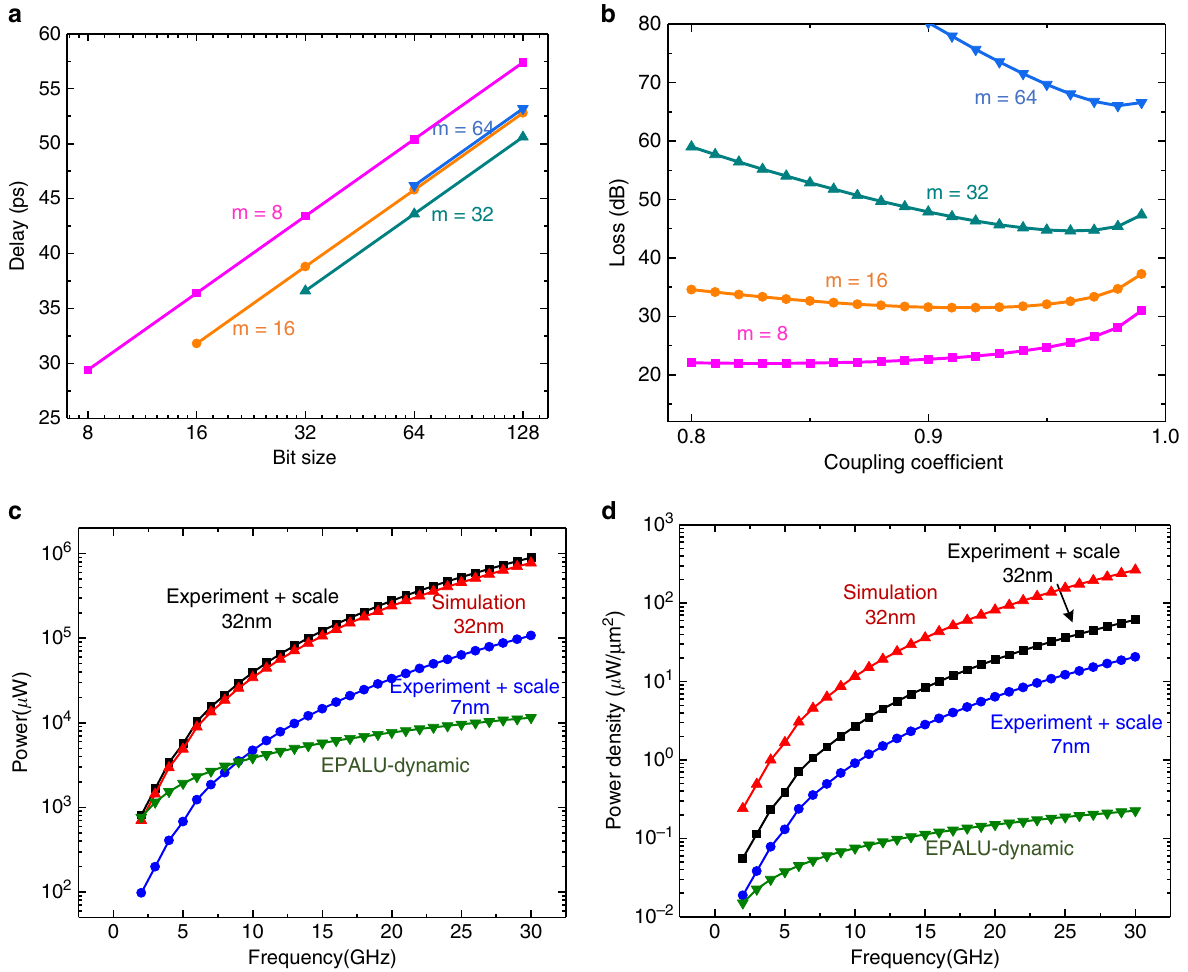
Fig. 4 Performance analysis. a The entire delay of proposed EPALU with respect to the bit size of the circuit, which also corresponds to the bit size m of each optical full adder. b The entire loss as a function of the coupling coef fi cient of the directional coupler. The optimal condition could be obtained for different bit size m . c Comparison of power consumption between 64-bit EPALU (dynamic power consumption) and conventional transistor-based ALU. The power consumption data on 32 and 7 nm technology node are calculated using the published experimental data (90 nm technology node) 27 and published accurate scaling equations 38 as well as commercial simulation tools. Note that the total power consumption of EPALU will be larger if taking laser and thermal tuning into consideration. See details in Supplementary Notes 6 and 7. d Comparison of the power